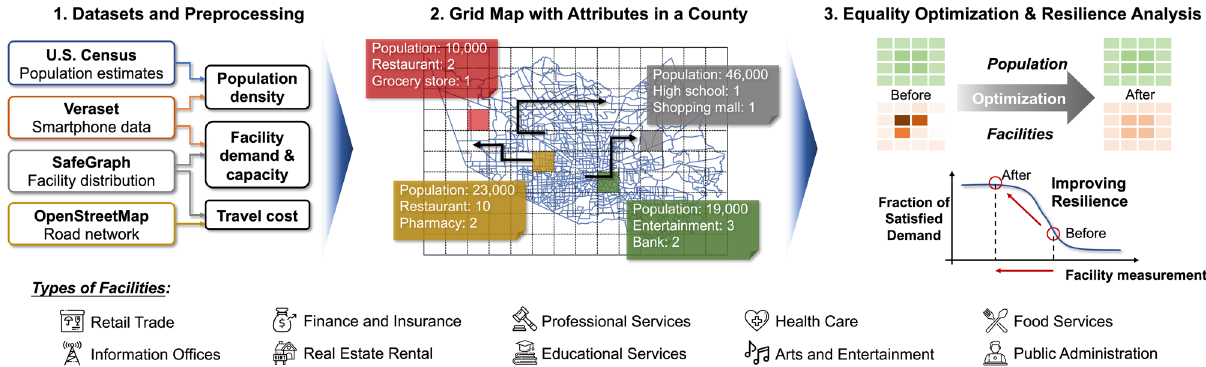
Fig. 1 Illustration of datasets, preprocessing steps, and the framework of this study. This study employed four large-scale datasets (census data, smartphone location data, facility information, and road networks) to generate the distribution of population, demand and capacity of the facilities, and travel costs. Then we created a grid map for each county, and each grid is associated with a set of attributes, such as population, facilities, and demand of residents. Finally, optimization and resilience models were developed to optimize the distributions of facilities and quantify the change in the resilience of a city. This study focuses on ten types of facilities in each county, such as retail trade, fi nance and insurance, information of fi ces, as shown in the bottom of this fi